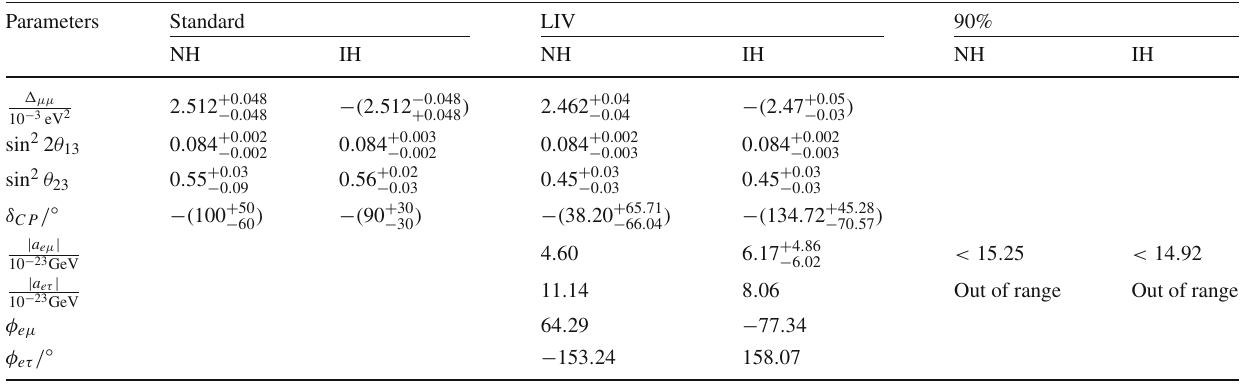
Table 3 Parameter values at the best-fit points for T2K.The 1 σ error bars have been mentioned where possible. The 90% limits for 1 d.o.f